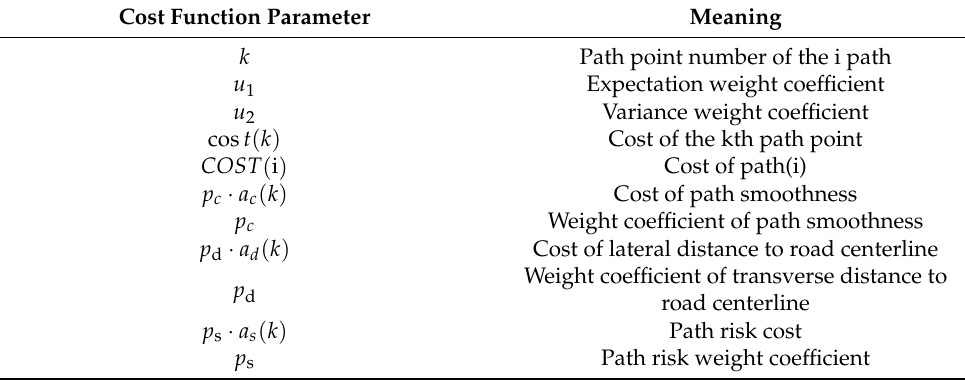
Table 3. Description of the parameters and evaluation terms in the cost function.